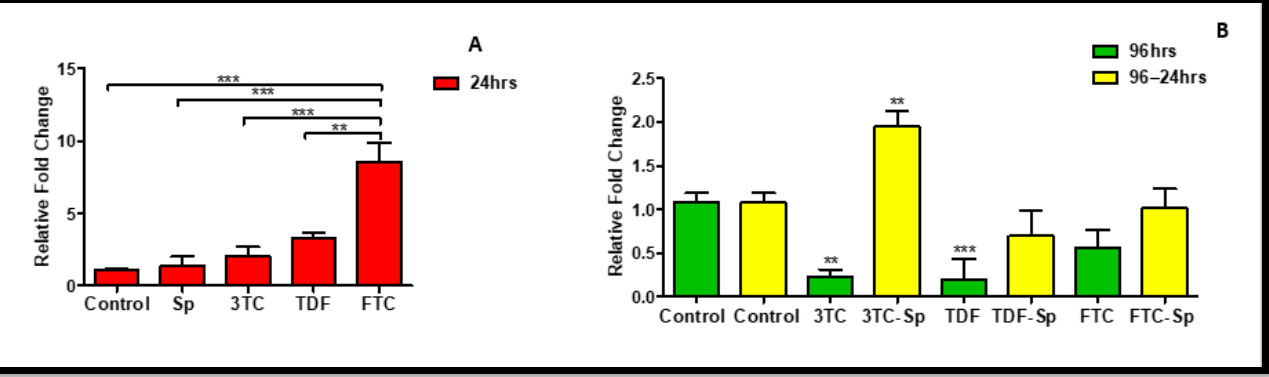
Figure 5.. Effects of SP and HAART (3TC, TDF, and FTC) on Keap1 mRNA levels. Keap1 mRNA levels after exposure of HepG2 cells to ( A ): SP and HAART for 24 h, ( B ): HAART (96 h), and HAART (96 h) followed by SP (24 h); ** p < 0.005, *** p < 0.0001.